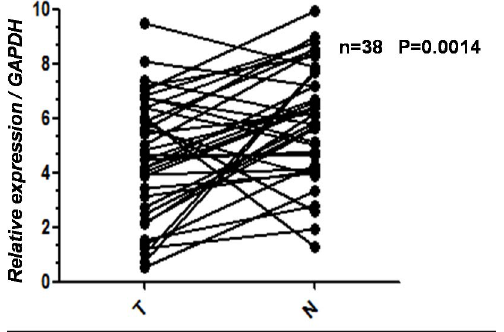
Figure 2. GATA3 protein expression in gastric cancer surgical specimens shown by immunohistochemistry. (A) Strong GATA3 staining ( +++ ) was observed in noncancerous gastric mucosa. (B) GATA3 staining ( ++ ) in well differentiated gastric cancer. (C) GATA3 staining ( + ) in poorly differentiated gastric cancer. (D). Negative GATA3 staining ( 2 ) in mucinous carcinoma.